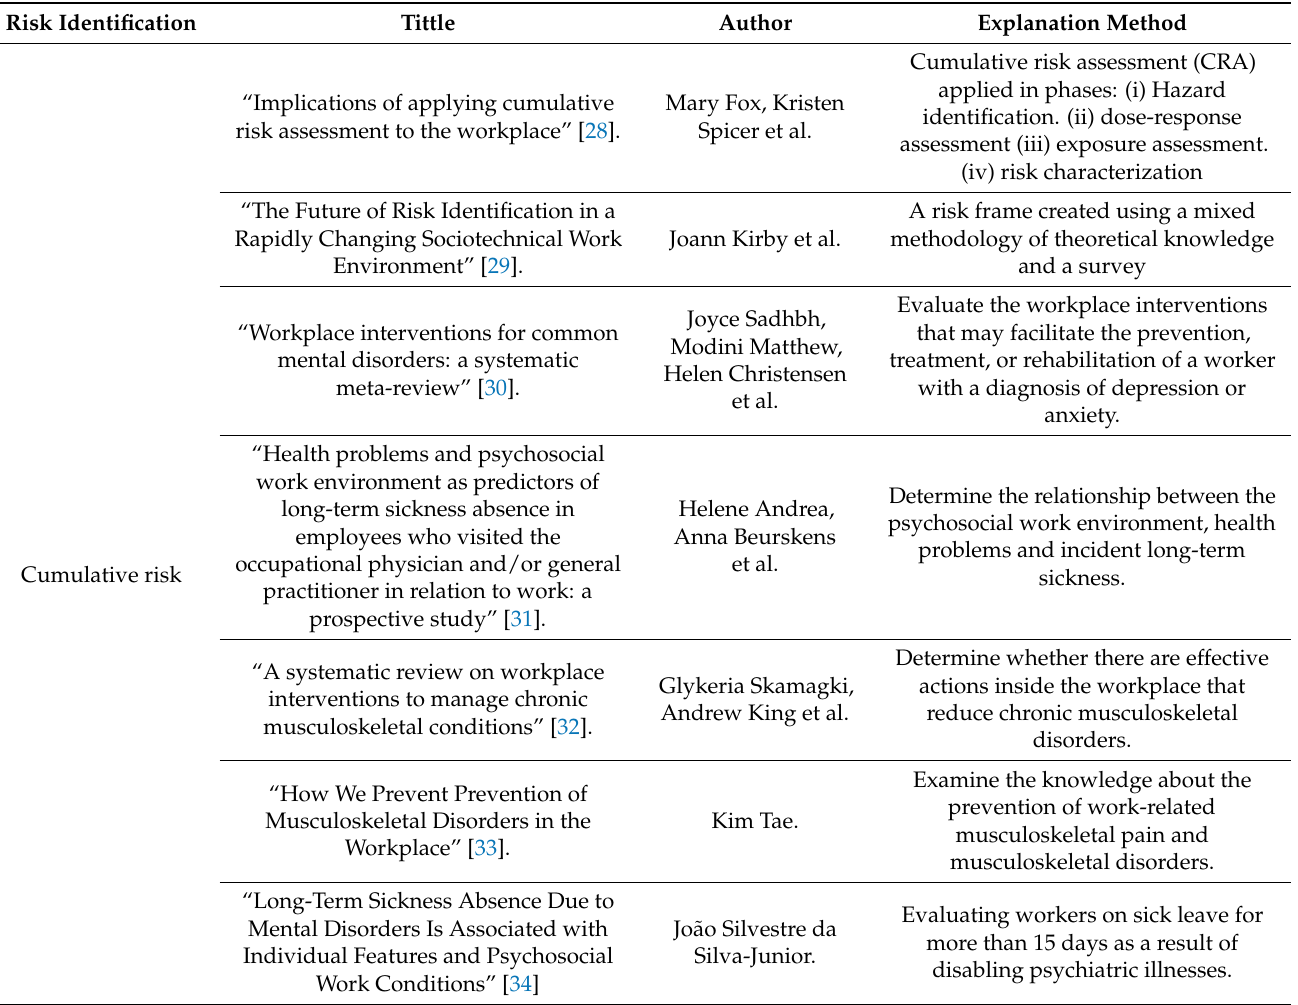
Table 1. Risk Identification